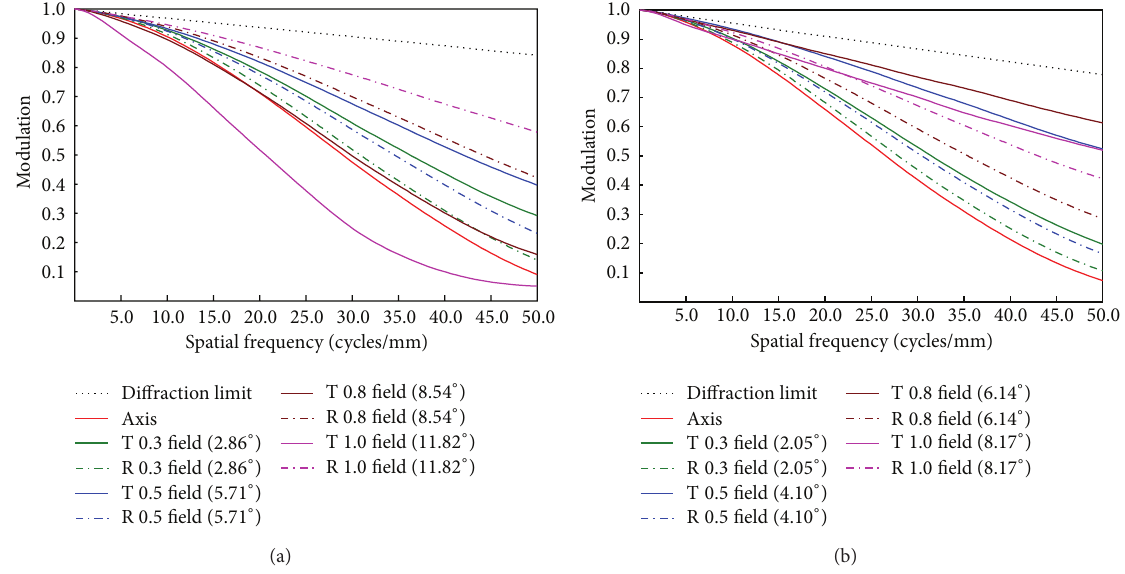
Figure 6: The modulation transformation function: (a) EFL = 5mm and (b) EFL = 7mm.